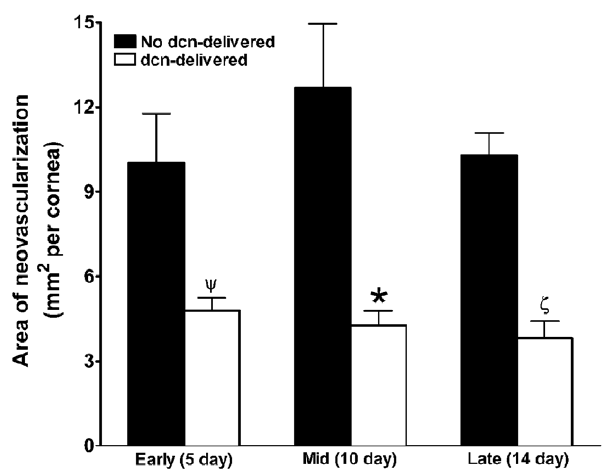
Figure 3. Morphometric quantification of CNV from different time points in rabbit eyes receiving AAV5 + / 2 decorin. Data was collected after day 5 (early), 10 (mid), and 14 (late) of VEGF implantation from the control (no decorin-delivered) and decorin-delivered rabbit corneas. AAV-mediated decorin gene therapy demonstrated statistically significant decrease at the three tested stages of the CNV in rabbit model in vivo . y =p , 0.05, *=p , 0.001, f =p , 0.01 compared to control. dcn=decorin.